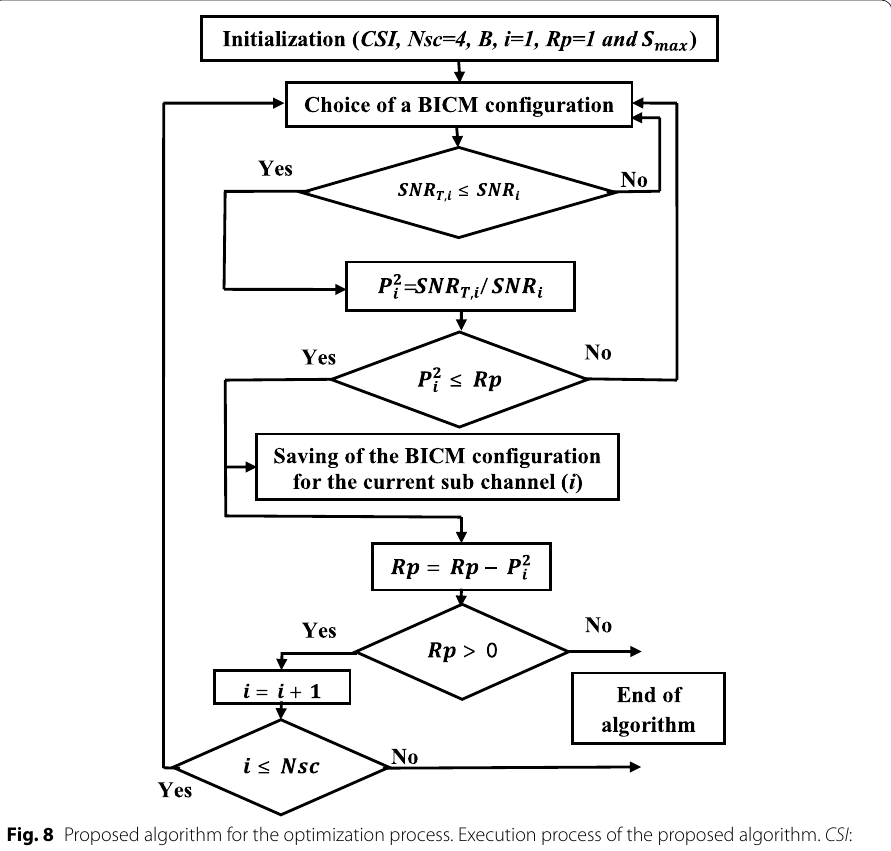
Fig. 8 Proposed algorithm for the optimization process. Execution process of the proposed algorithm. CSI : Channel state information. Nsc : Maximum number of sub-channels. B : Target BER. i : Index of the current sub-channel. Rp : Residual